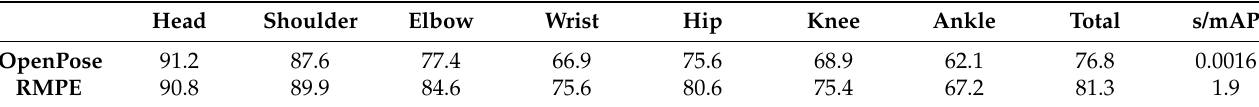
Table 1. MPII dataset experimental results.